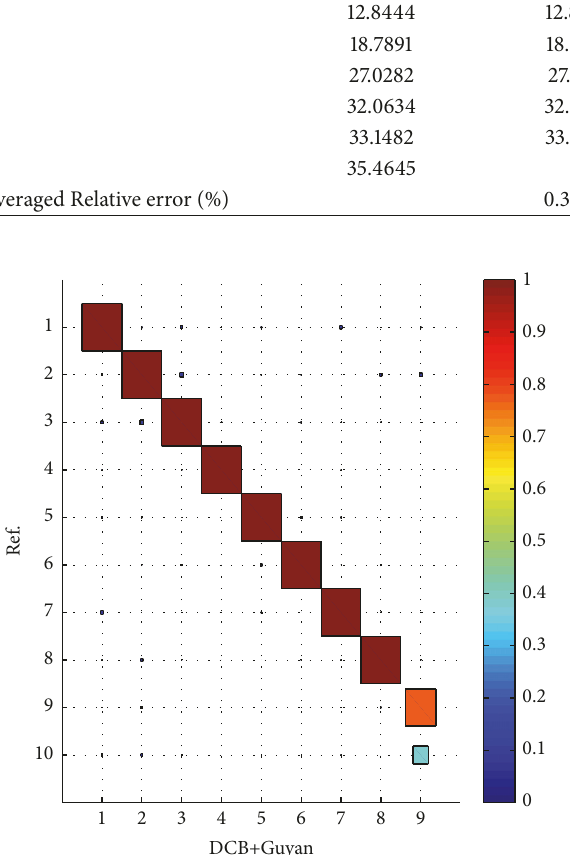
Figure 4: MAC analysis between accurate shapes and shapes from DCB+Guyan.